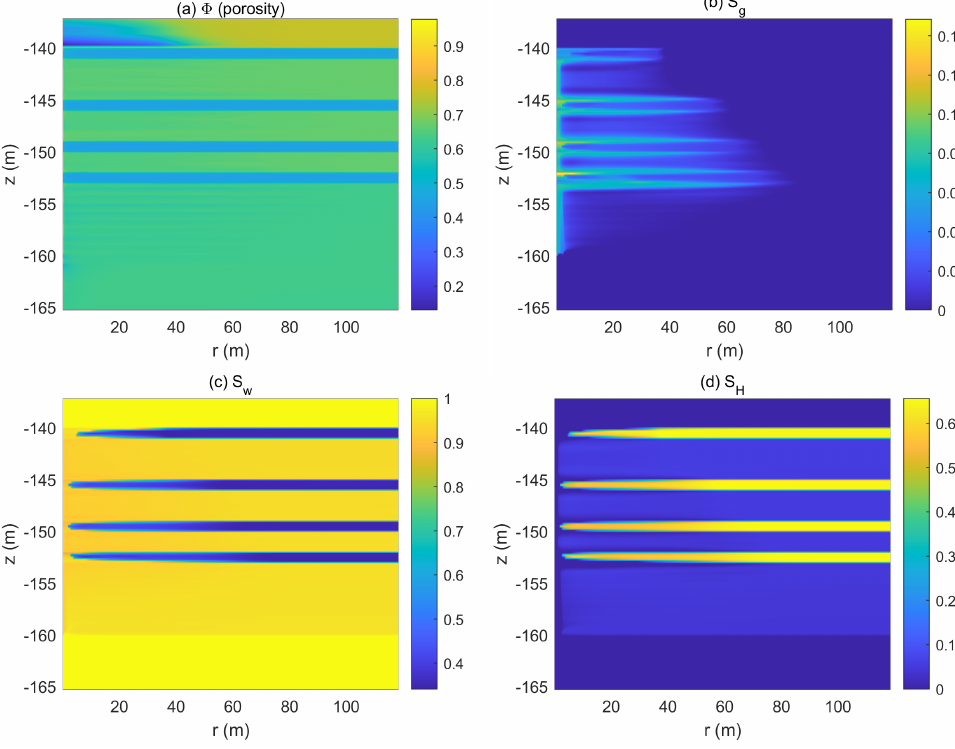
Figure 6. Porosity and saturations of gas, water, and hydrate after 100